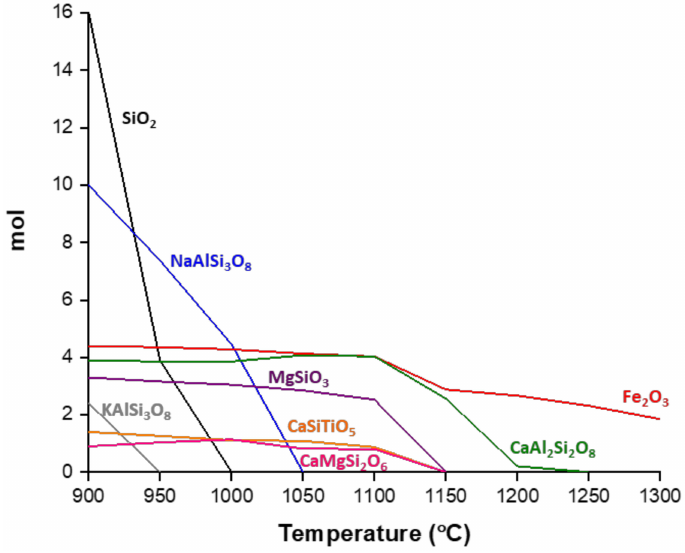
Figure 8. Expected phase formations in the volcanic ash glass as a function of temperature, calculated using the FactSage Equilibrium